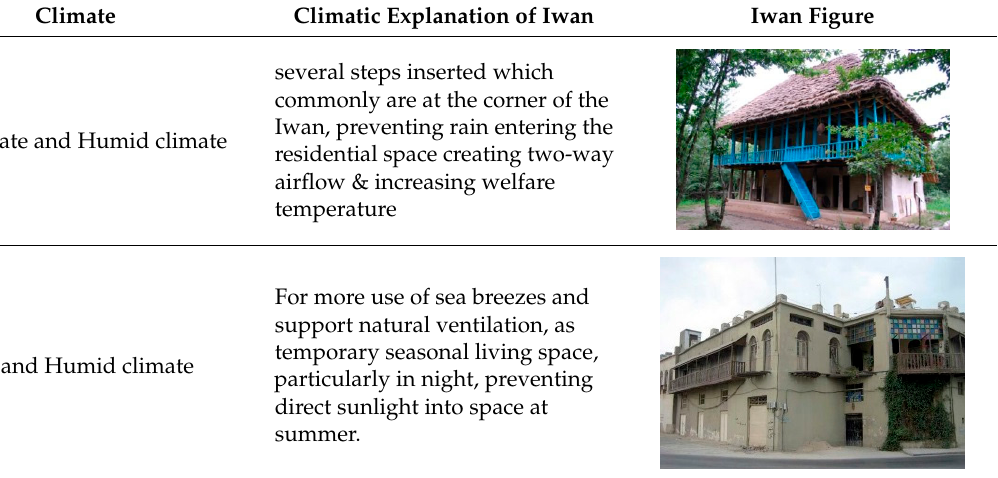
Table 2. Classification of climates of four different regions.